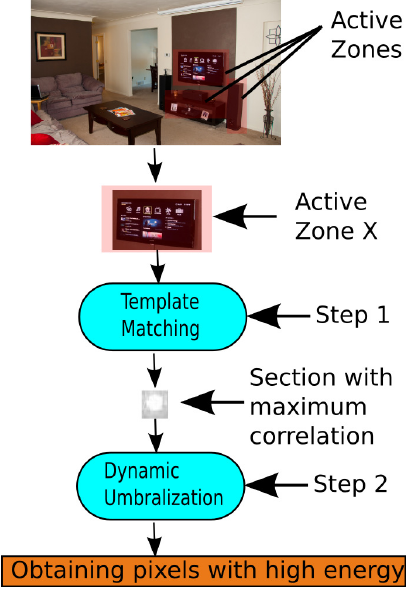
Fig. 5. TM + DU working